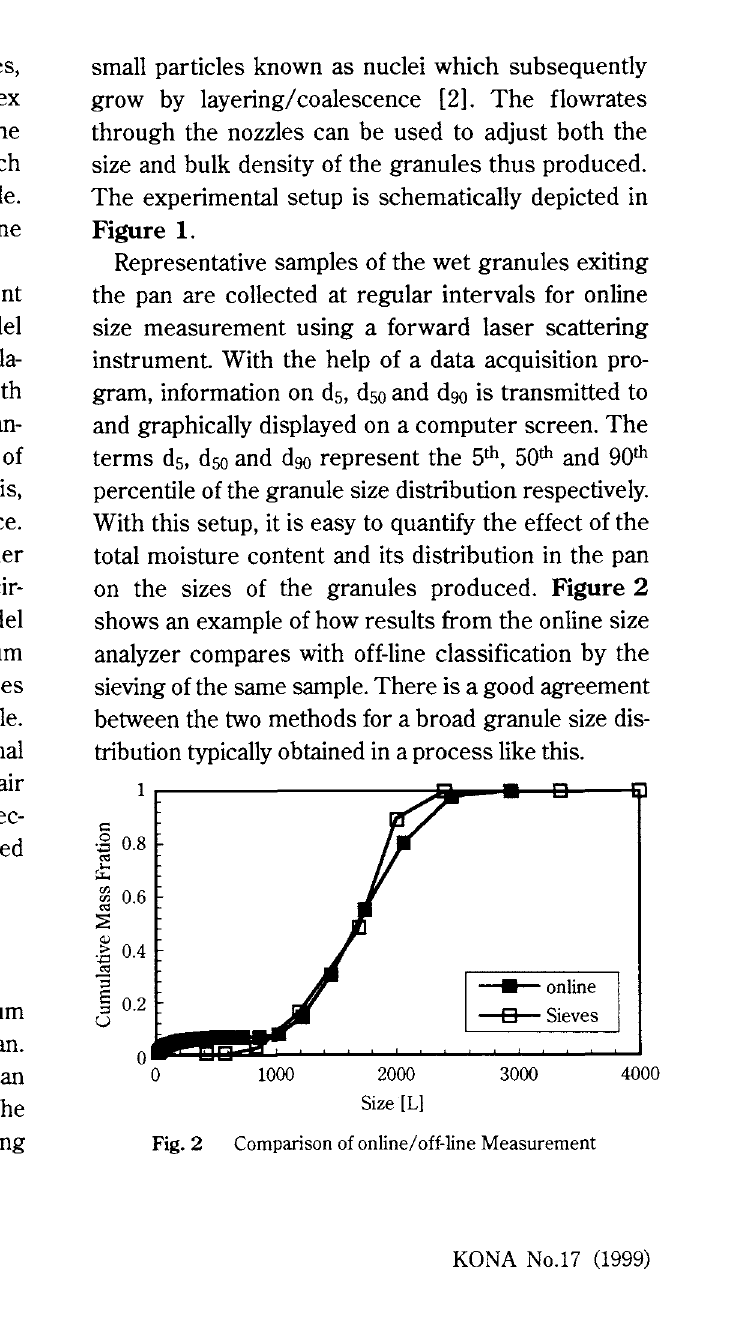
Fig. I Schematic Diagram of the Experimental Setup